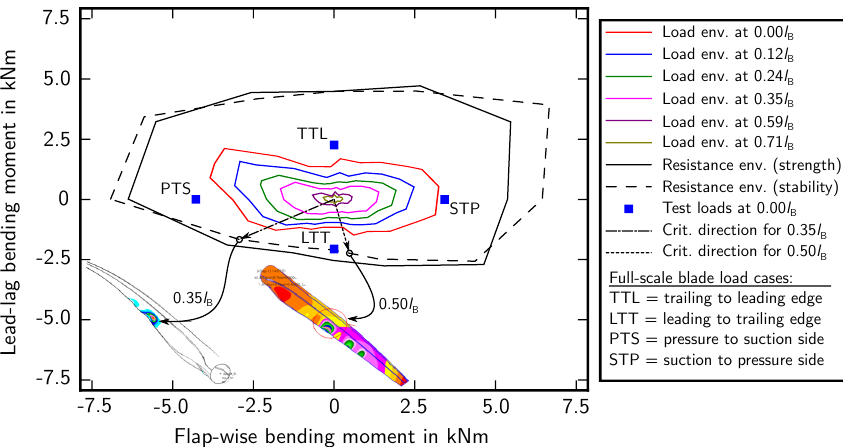
Figure 2. Load envelopes in terms of moment vectors determined from aeroservoelastic simulations for several cross sections of a 34m blade and certification test loads contrasted with strength and stability resistance of the whole blade’s cross sections from 0 to 100% blade length ( l B ) in terms of the root bending moment (excerpt from Branner et al. (2015)). The two moment vectors represent the critical load directions at 35 and 50% l B